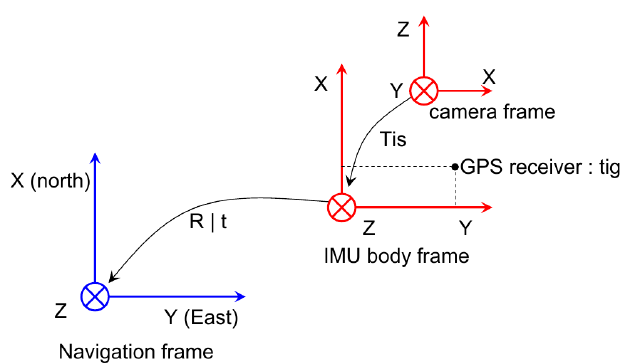
Figure 7. Definition of coordinate frames for EKF state estimation. The navigation frame (or world frame) is a local NED (North-East-Down) frame. The transforms R and t from the IMU body frame to the navigation frame will be estimated by the EKF. The parameters T is (from the camera frame to the IMU body frame) and t ig (GPS receiver coordinate in IMU body frame) are obtained by